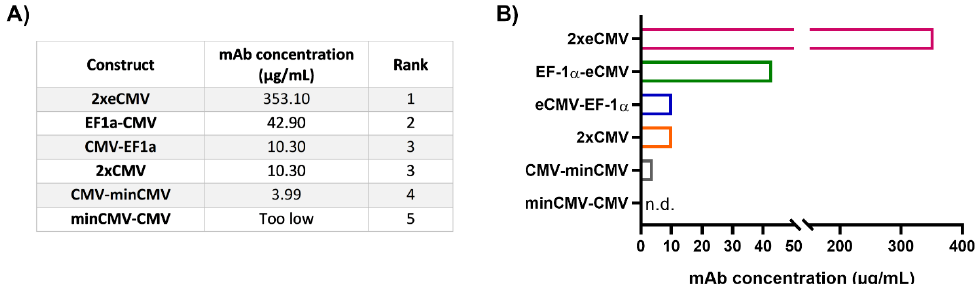
Figure 5. Protein quantification of Durvalumab in cell culture supernatants from transfected Expi293-F cells. ( A ) Table showing the mAb concentrations from 24-well transient transfections, listed according to their rank. The ranks 1–5 were set based on the mAb concentration of the different BiDi combinations. ( B ) Bar chart representation of BiDi mAb concentrations.